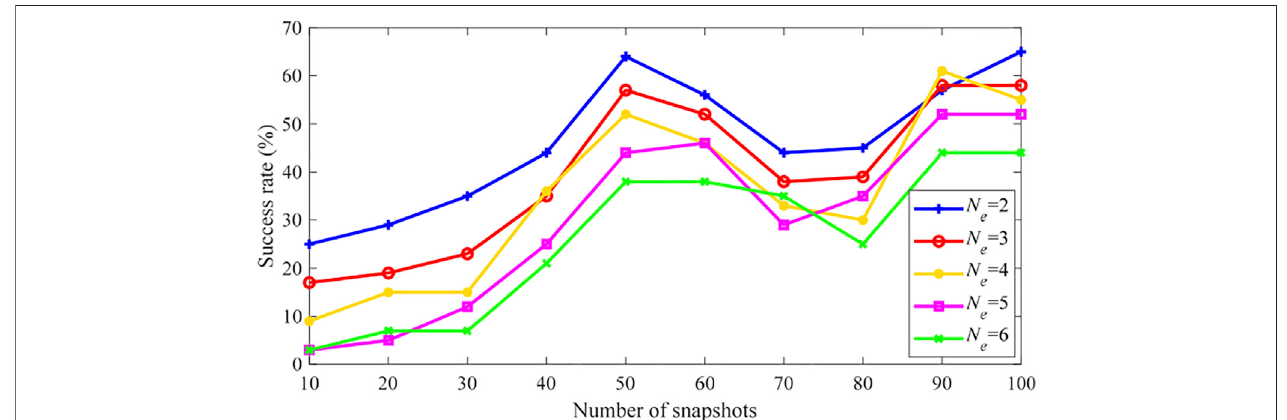
FIGURE 7 | PEI success rate of the IEEE 30-bus system using empirical MEVs (Case 1).